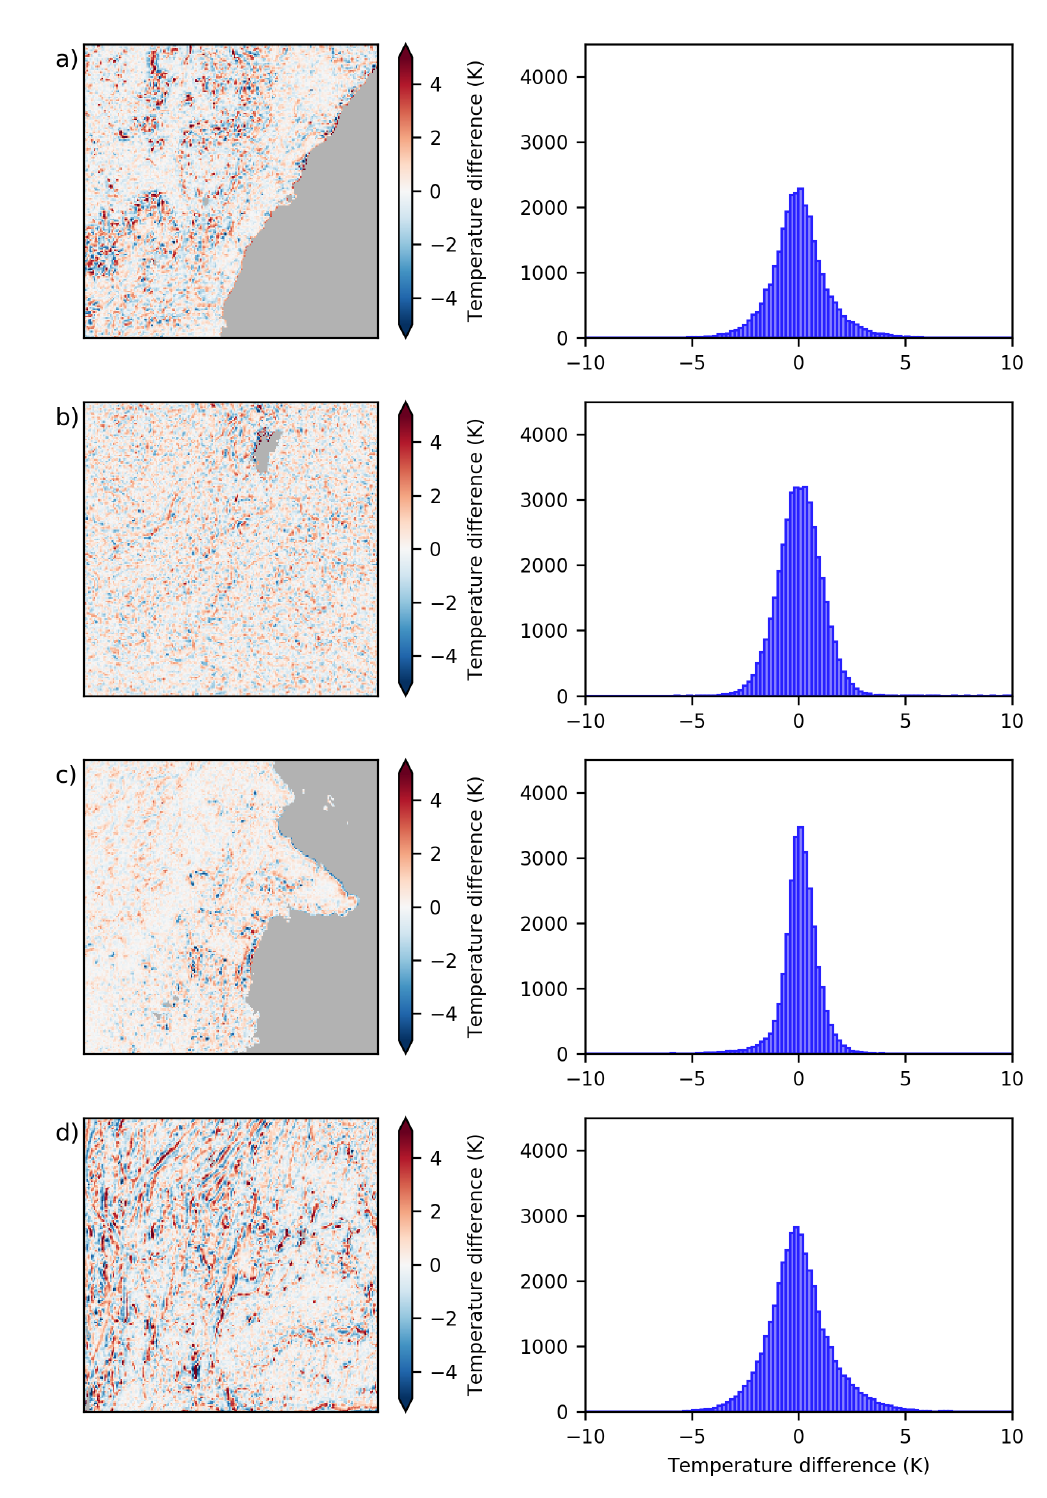
Figure 6. Mean difference between contextual estimates and the central pixel for the selected period for each area. ( a ) south-eastern Australia (sea); ( b ) north-western Australia (nwa); ( c ) Borneo (bor); and ( d ) central Thailand